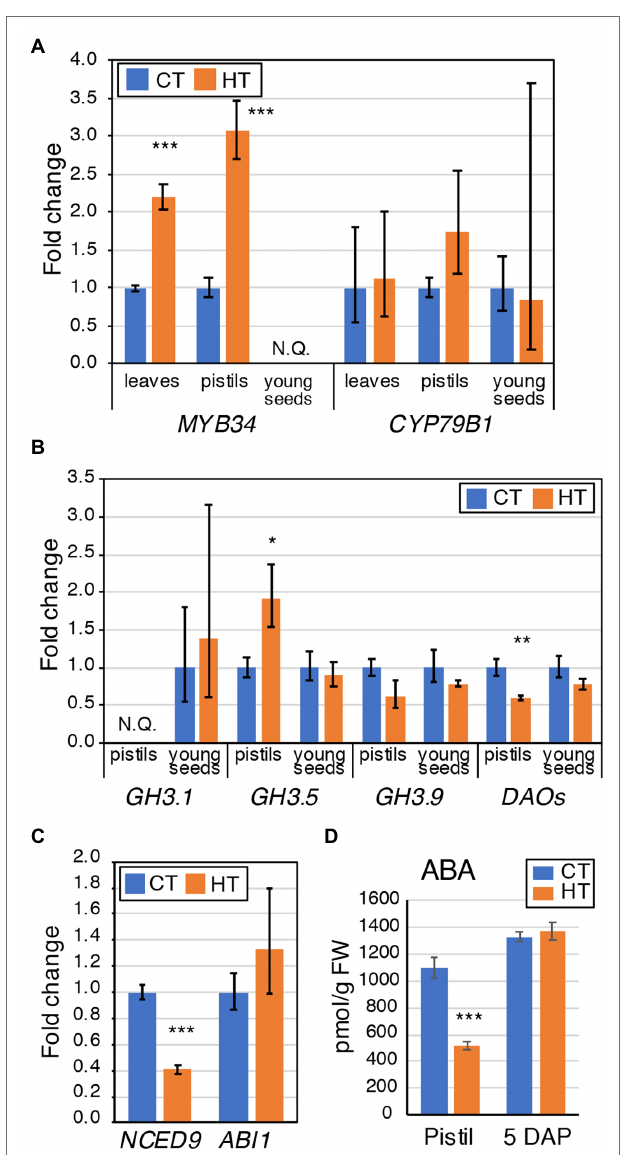
FIGURE 3 | Expression analysis of genes involved in auxin homeostasis and ABA levels in Westar leaves, pistils, and young seeds. (A) Expression analysis by RT-qPCR of BnaMYB4 and BnaCYP79Bs in Westar leaves (blue), pistils (orange), and young seeds (grey). (B) Expression analysis by RT-qPCR of BnaGH3.1 (blue), BnaGH3.5 (orange), BnaGH3.9 (grey), and BnaDAOs (yellow) in Westar leaves, pistils, and young seeds. NQ, not quantified. (C) Expression analysis by RT-qPCR of BnaNCED9 and BnaABA1 in Westar pistils (blue). (A–C) The graphs display the fold changes in expression between CT (blue) and HT (orange). Asterisks indicate statistically significant difference in HT in a paired Student’s t -test ( t -test; *, **, and *** correspond to value of p 0.05 > p > 0.01, 0.01 > p > 0.001, and p < 0.001, respectively). Primers and LOC information are presented in Supplementary Table S1 . (D) Graph showing the ABA levels (in pmol/g FW) in Westar pistils and 5 DAP seeds grown at CT and HT. Shown is the average ± SD. Asterisks indicate a statistically significant difference in HT in a paired Student’s t -test ( t -test; *** corresponds to value of p < 0.001). Source data are presented in Supplementary Table S4